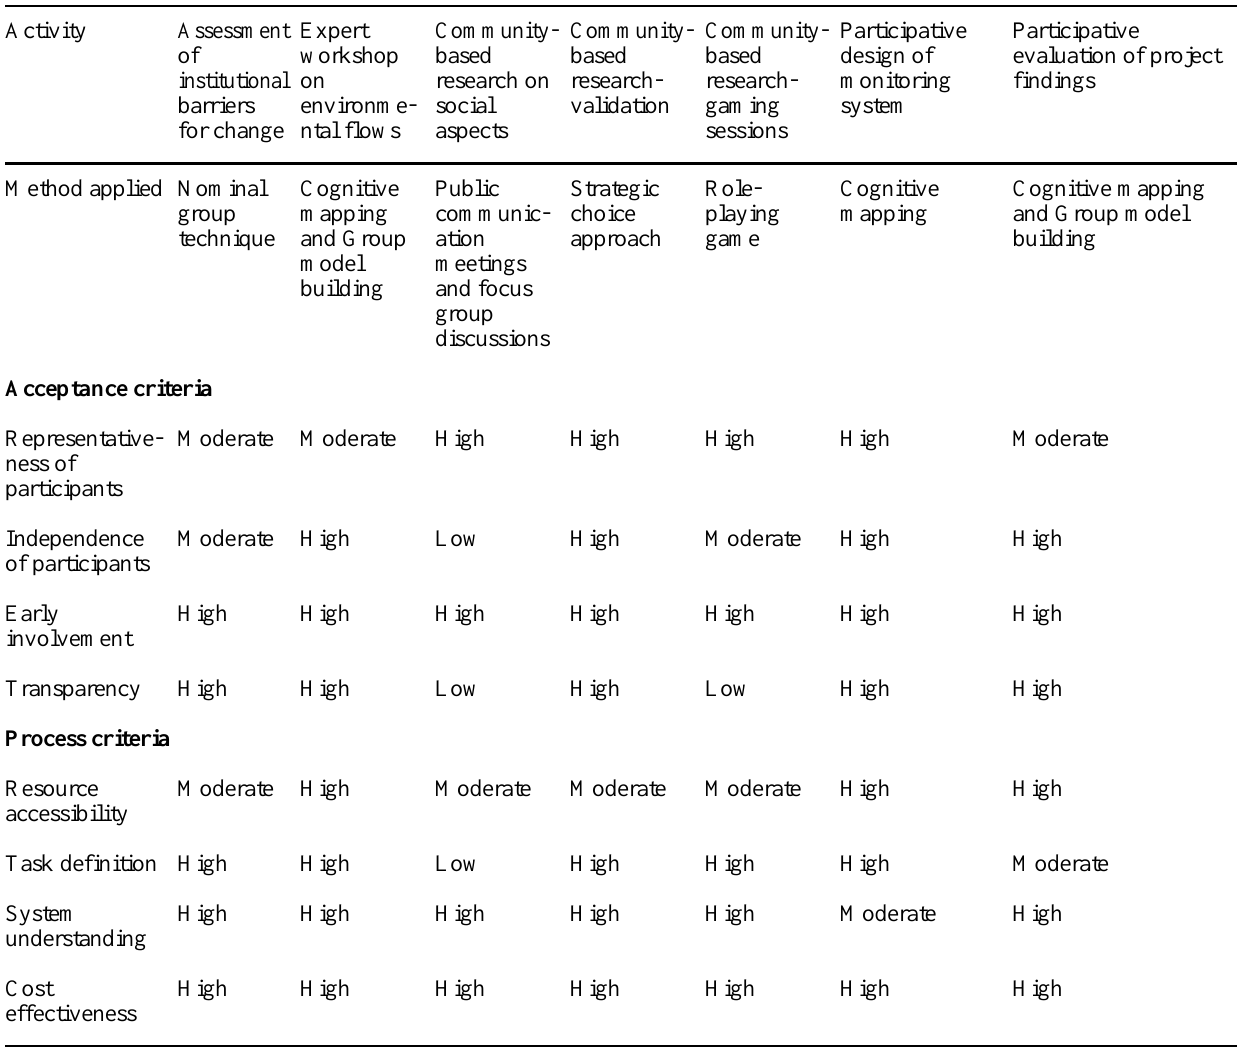
Table 4 . Evaluation of the participative process (adapted from Rowe and Frewer